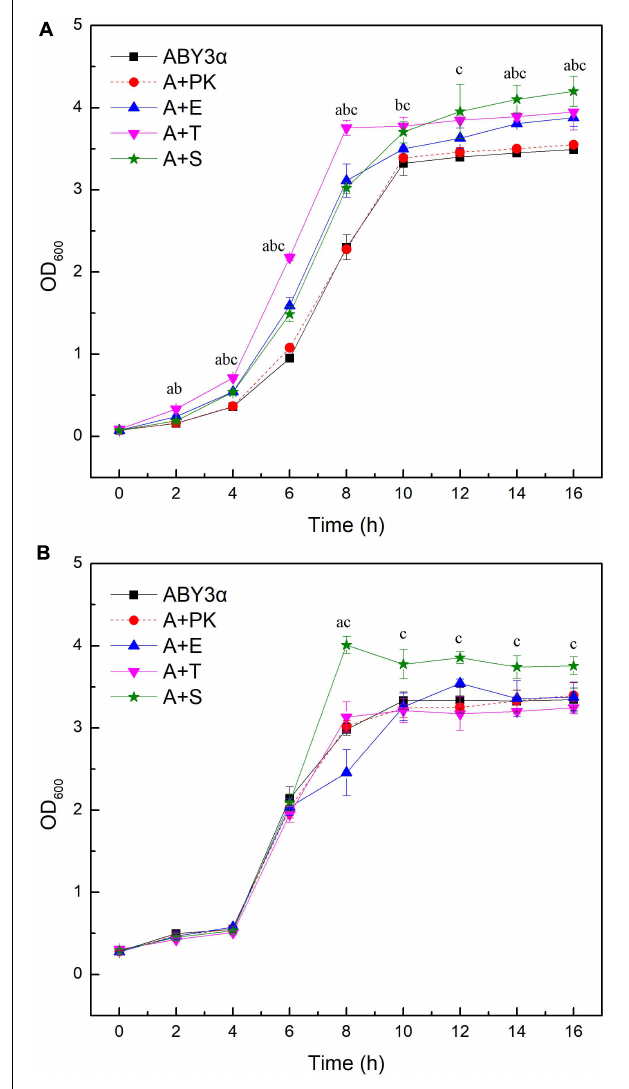
FIGURE 2 | Growth curves of the strains carrying genes overexpression. Growth curves were monitored in (A) 2% glucose (YEPD medium) and (B) 2% maltose (YEPM medium consisted of 20 g/L maltose, 20 g/L peptone, and 10 g/L yeast extract) conditions at appropriate time intervals at 30 ◦ C. ABY3 α , the parental strain; A+PK, the strain carrying the vector Yep-PK used as a blank control to demonstrate any possible effect of the empty vector; A+E, the transformant carrying ELM1 overexpression; A+T, the transformant carrying TOS3 overexpression; A+S, the transformant carrying SAK1 overexpression. Significant differences of the transformants A+E, A+T, and A+S to the parental strain were confirmed at a p < 0.05, b p < 0.05, and c p < 0.05, respectively.